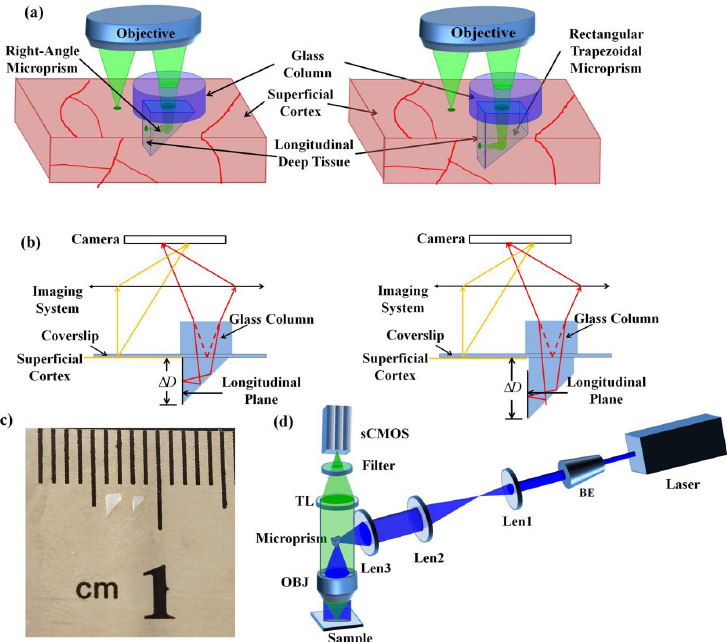
Figure 1. Schematic diagram of the multi-plane imaging technique. ( a ) Schematic of the experimental setup showing the microprism implant. ( b ) Schematic diagram of simultaneous imaging of side and top views. ( c ) Rectangular trapezoidal microprism (left) and right-angle microprism (right). ( d ) The scheme of the customized-built wide-field mesoscope, with brain-wide FOV and cellular resolution. BE: Beam expander; OBJ: Objective; TL: Tube